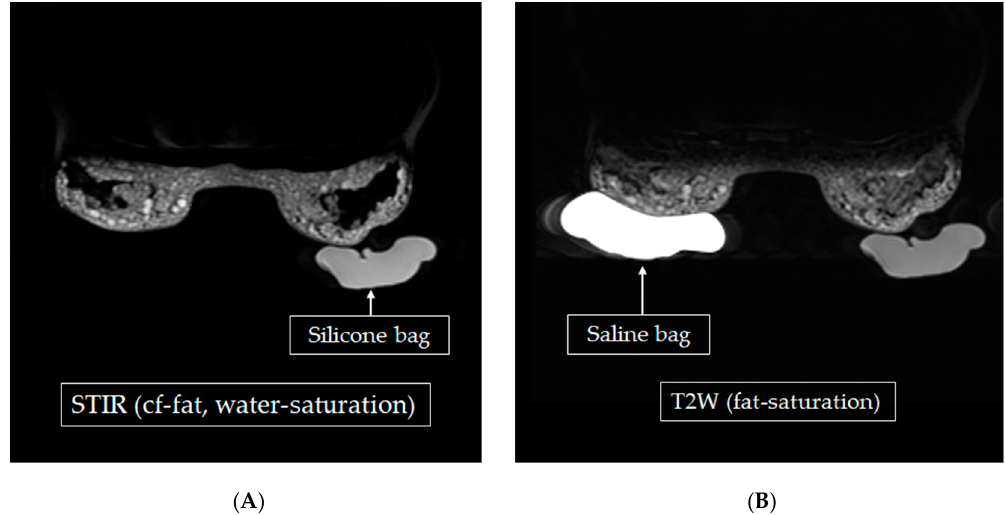
Figure 4. Two magnetic resonance imaging techniques were applied to identify implants of different materials. ( A ) silicone-enhanced image with STIR water-saturation and ( B ) water-enhanced image with T2W fat-saturation.